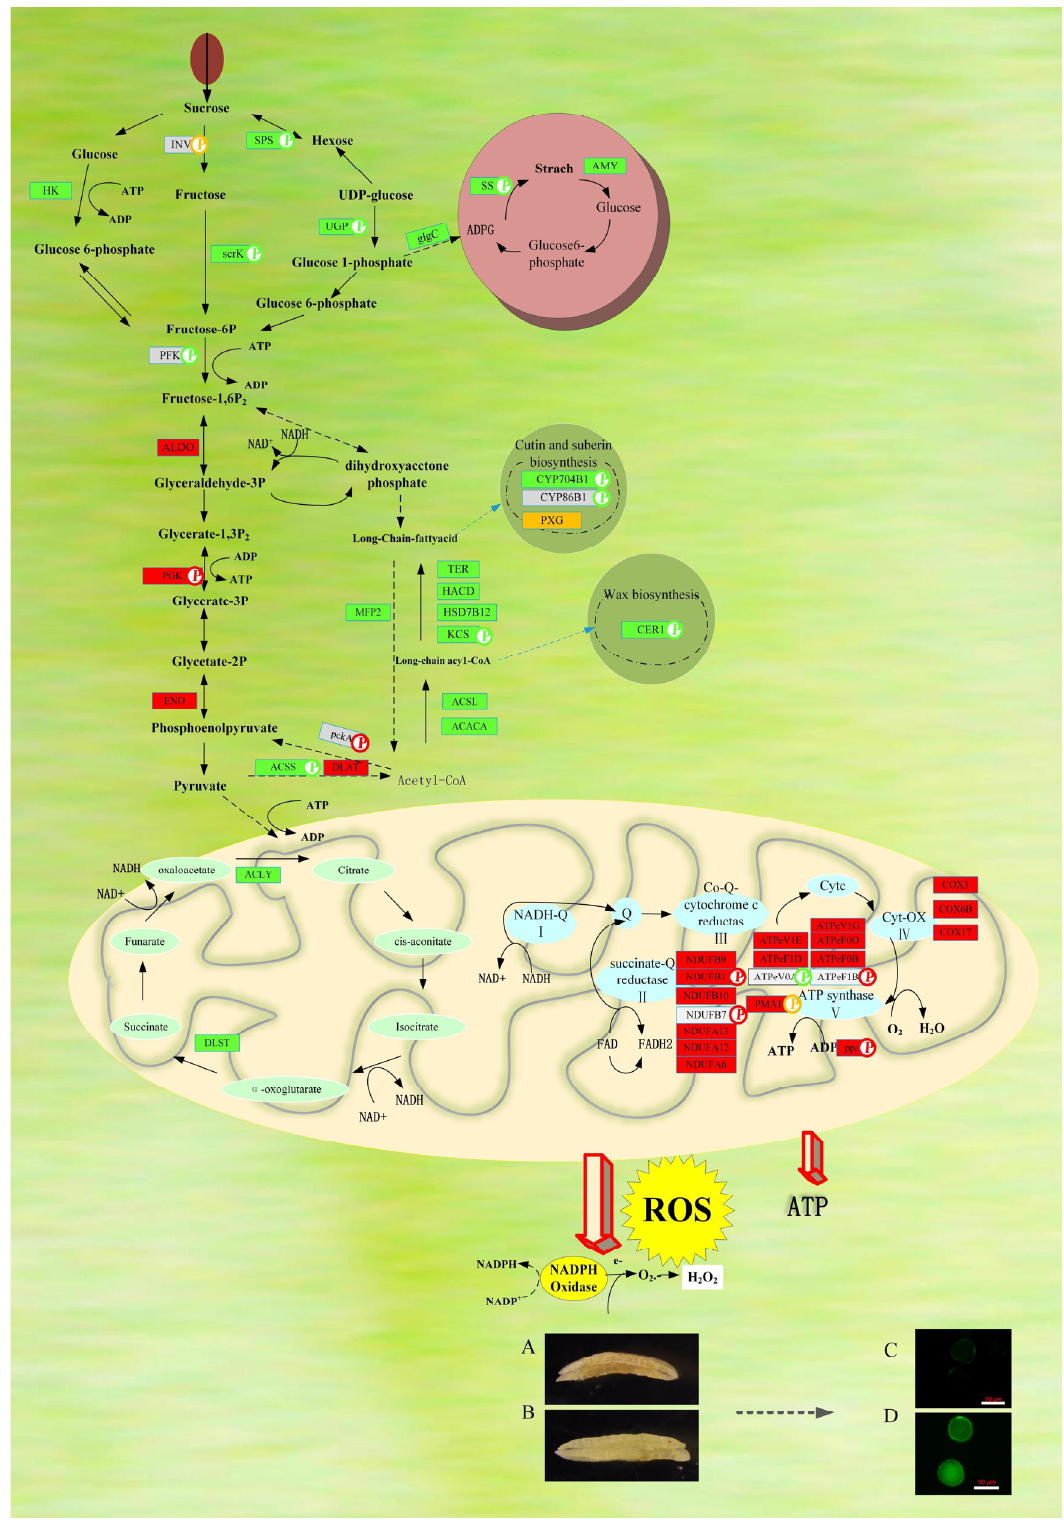
Figure 10. Schematic overview of the metabolic pathways associated with the differentially expressed proteins identified in pollen abortion of YS3038. DAB staining of ( A ) YS3038-A and ( B ) TabYS3038-B. FDA staining of ( C ) YS3038-A and ( D ) YS3038-B. Figure 10 is drawn by me using Visio according to our experimental results on the basis Supplementary Materials Tables S4–S6 in article of Wang et al. (2019) [29] . Protein names in gray indicate they were not observed in our proteomic dataset, P in a circle indicates phosphoproteins, green indicates down-regulation, red indicates up-regulation, yellow indicates both up- and down-regulation.